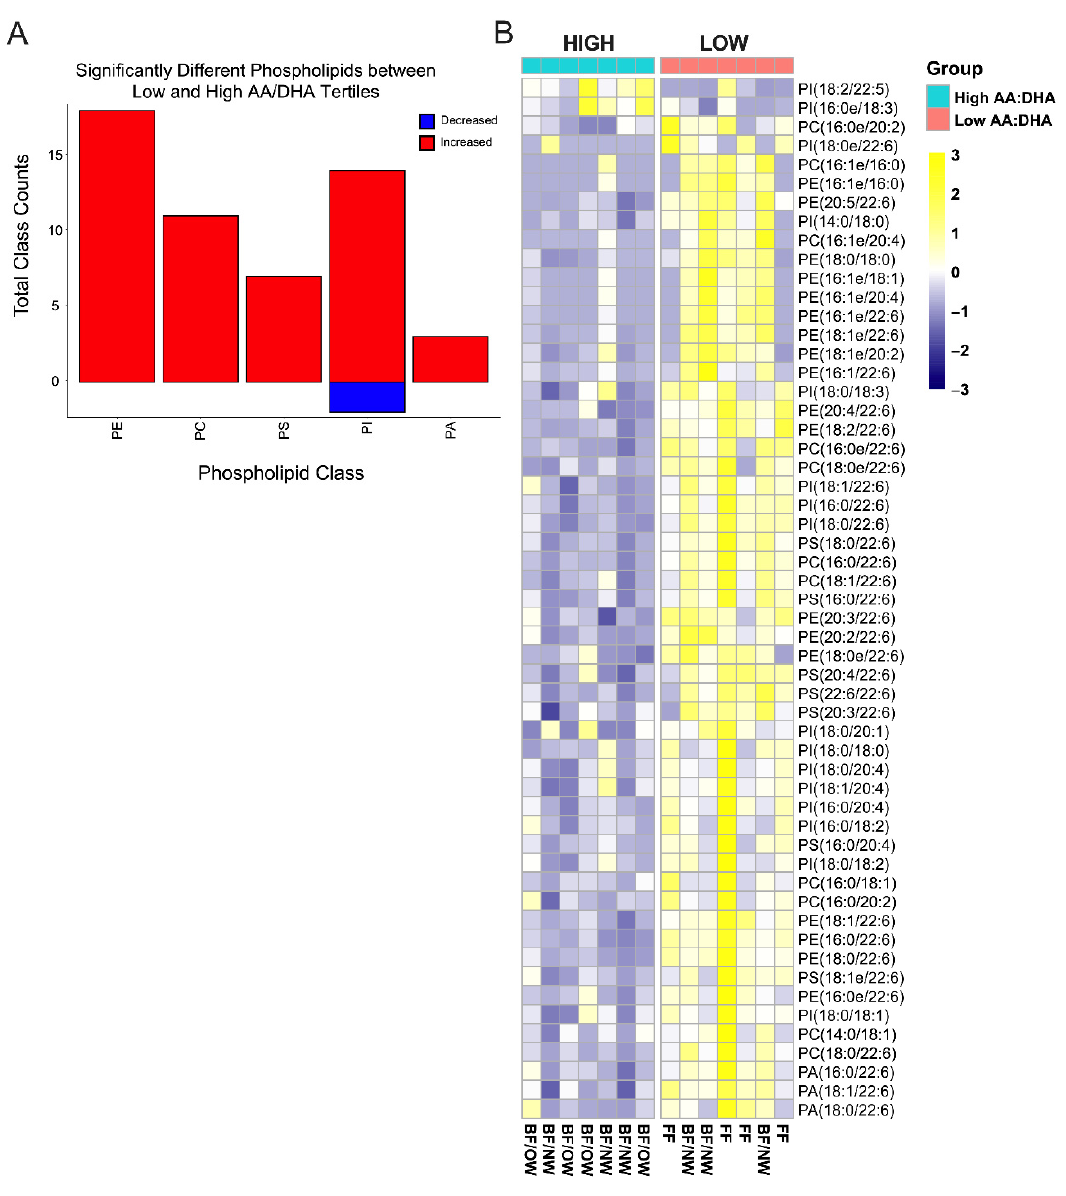
Figure 4. Most significantly different infant RBC phospholipids are increased when grouped by infant RBC total fatty acid AA/DHA ratio. ( A ) Individual classes of phospholipids that are significantly increased or decreased relative to the high AA:DHA ratio and are organized by classes, including phosphatidylethanolamine (PE; 18 increased), phosphatidylcholine (PC; 11 increased), phosphatidylserine (PS; 7 increased), phosphatidylinositol (PI; 13 increased and 2 decreased), and phosphatidic acid (PA; 3 increased). ( B ) Significantly different phospholipids between high and low AA/DHA tertile groups making up each of the phospholipid classes presented in A are plotted by heatmap. ( p < 0.05 by 1-way ANOVA, Heatmap labels: BF/NW = breastfed infants/normal weight mothers, BF/OW = breastfed infants/overweight mothers, FF = predominantly formula fed infants; n = 7 High and 7 Low).